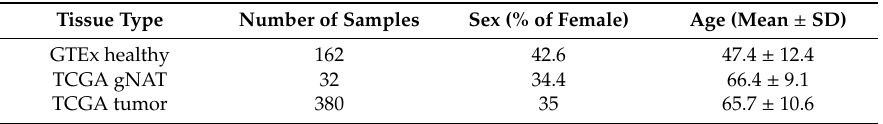
Table 1. Distribution of samples and demographic characteristics of patients and healthy donors included in the study. GTEx: Genotype-Tissue Expression project; TCGA: The Cancer Genome Atlas; gNAT: gastric normal tissue adjacent to the